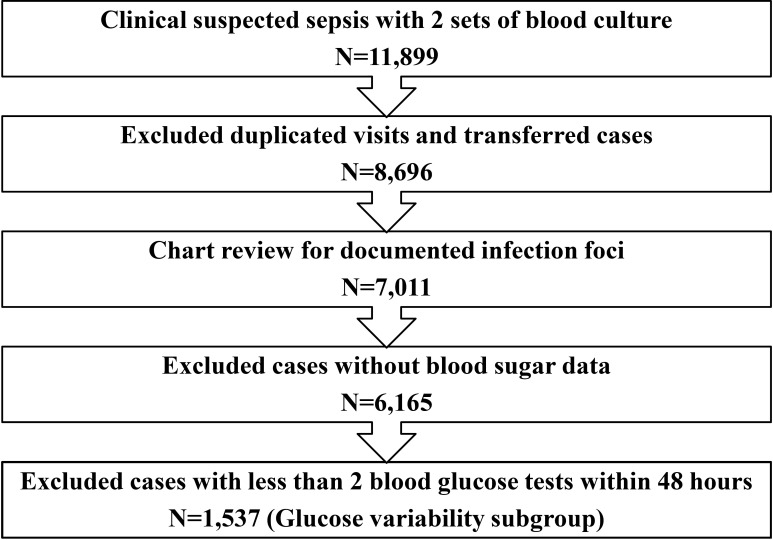
Patient flow chart.